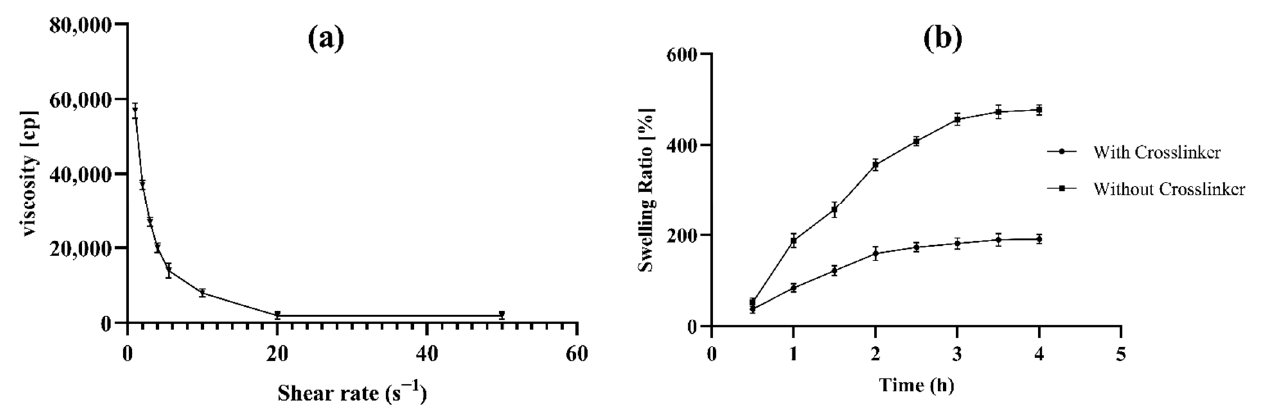
Figure 4. ( a ) Rheology of hydrogel; ( b ) swelling index of lyophilised hydrogel with and without cross cross linker.